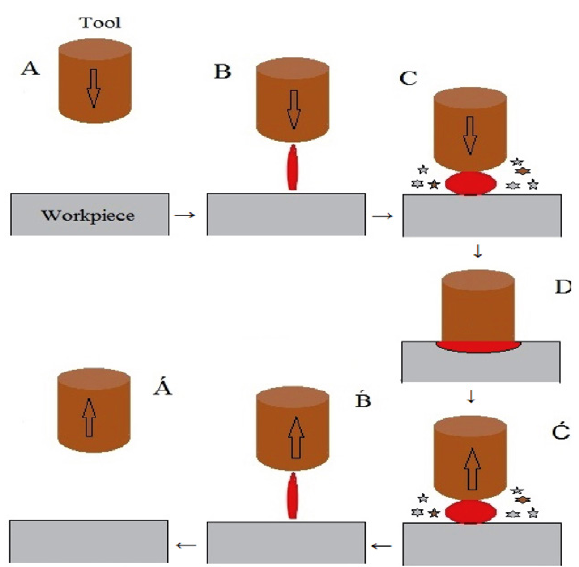
Figure 4. Schematic of the copper diffusion mechanism during EDM.